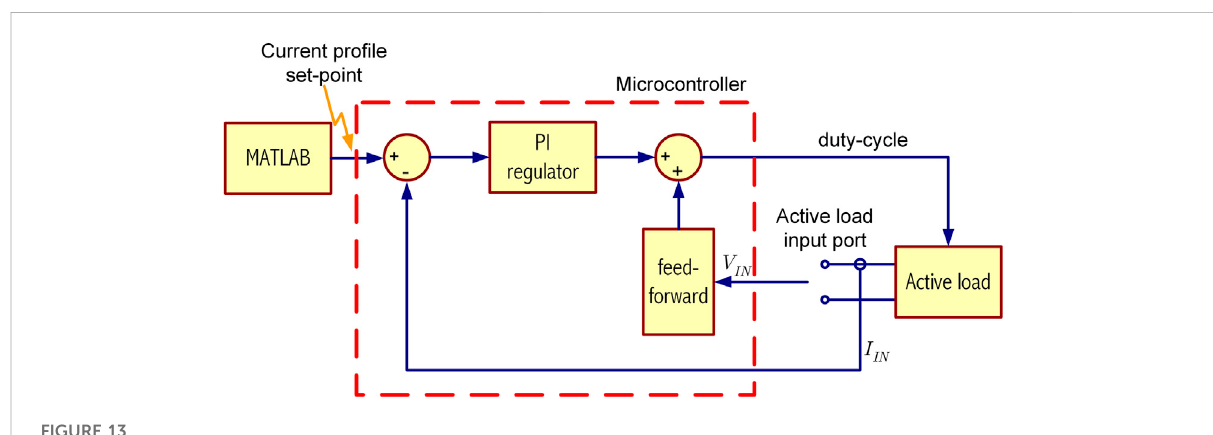
FIGURE 13 Block diagram of the Active Load control